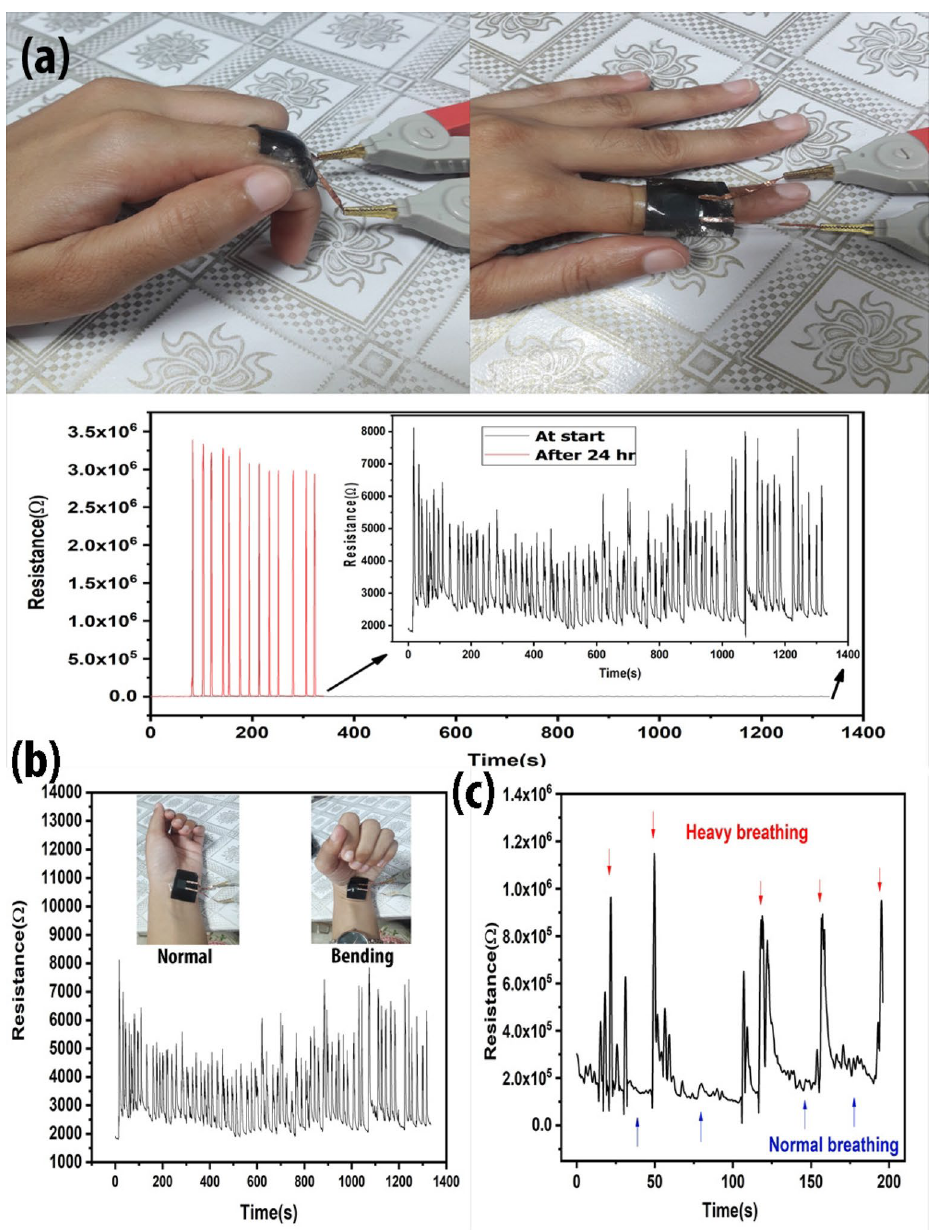
Figure 6. Application of the strain sensor ( a ) Sensor was applied to human finger for 24 h, stretching tests were performed at the start and end of the experiment by bending the finger at an angle between 110° to 120°. ( b ) Sensor was applied to the human hand for muscle motion detection for 24 h while measuring the stretching and compression movement of hand. ( c ) The resistance fluctuates by pulse rate resulting after a change in